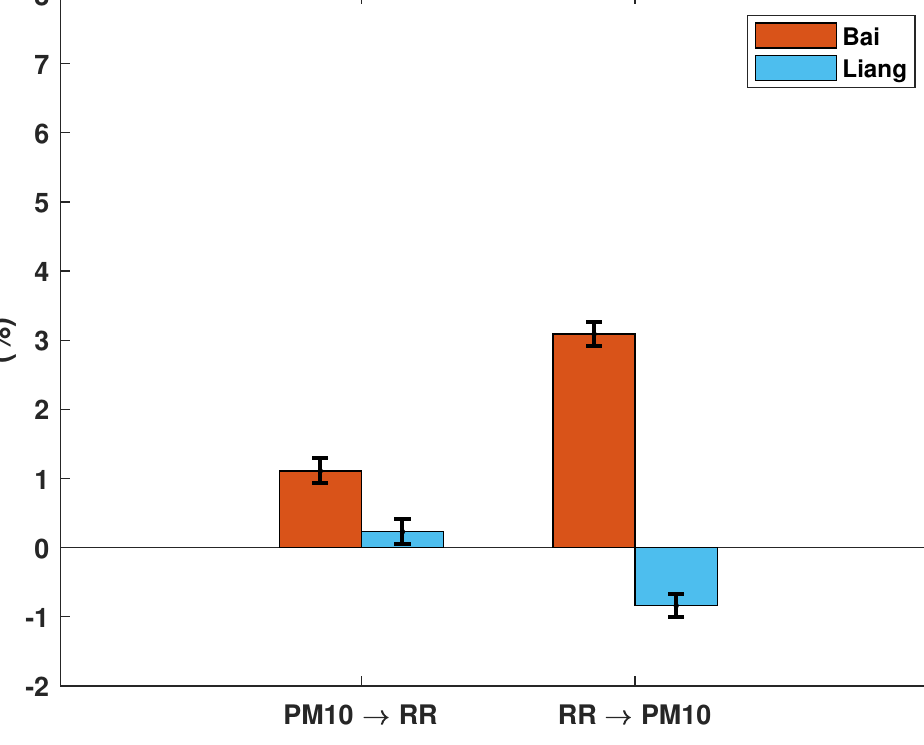
Figure 5. Relative information flow from PM 10 to RR and RR to PM 10 over 11 years using Bai ( τ B , in orange) and Liang ( T L , in blue) methods. The standard error (95% significance level) is represented by the